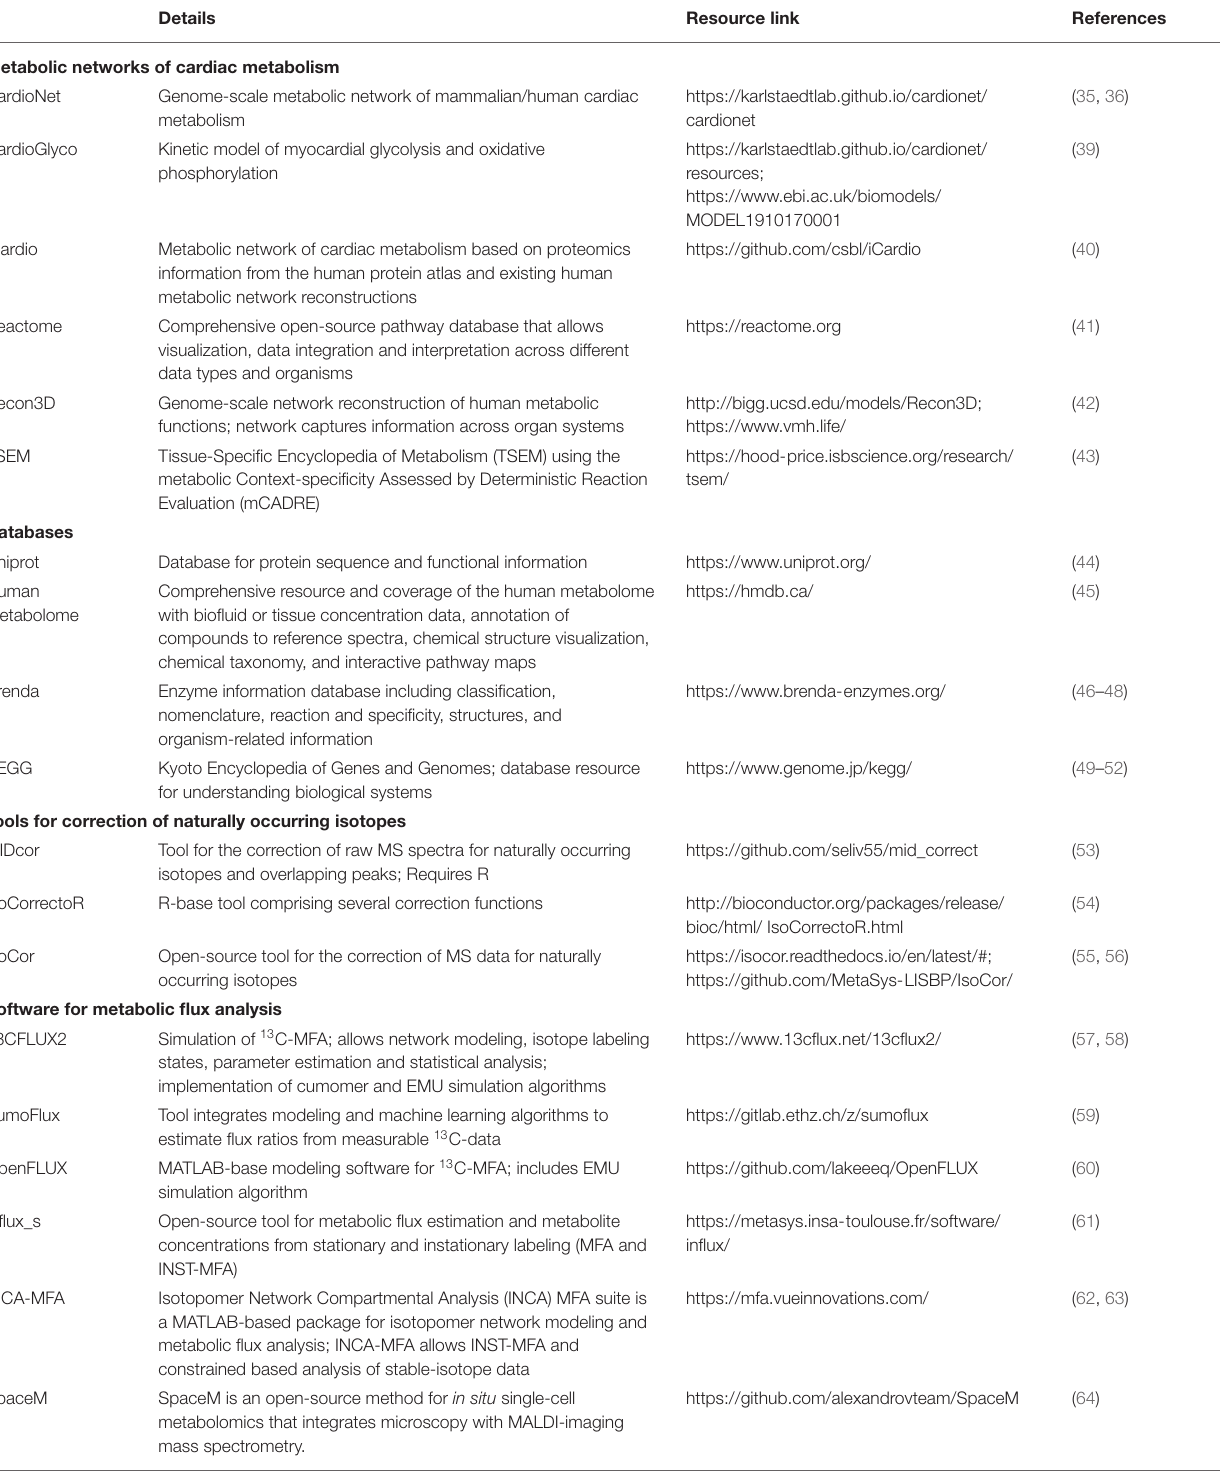
TABLE 2 | Resources for network reconstruction, simulation and visualization of metabolic flux analysis using stable-isotope tracers.